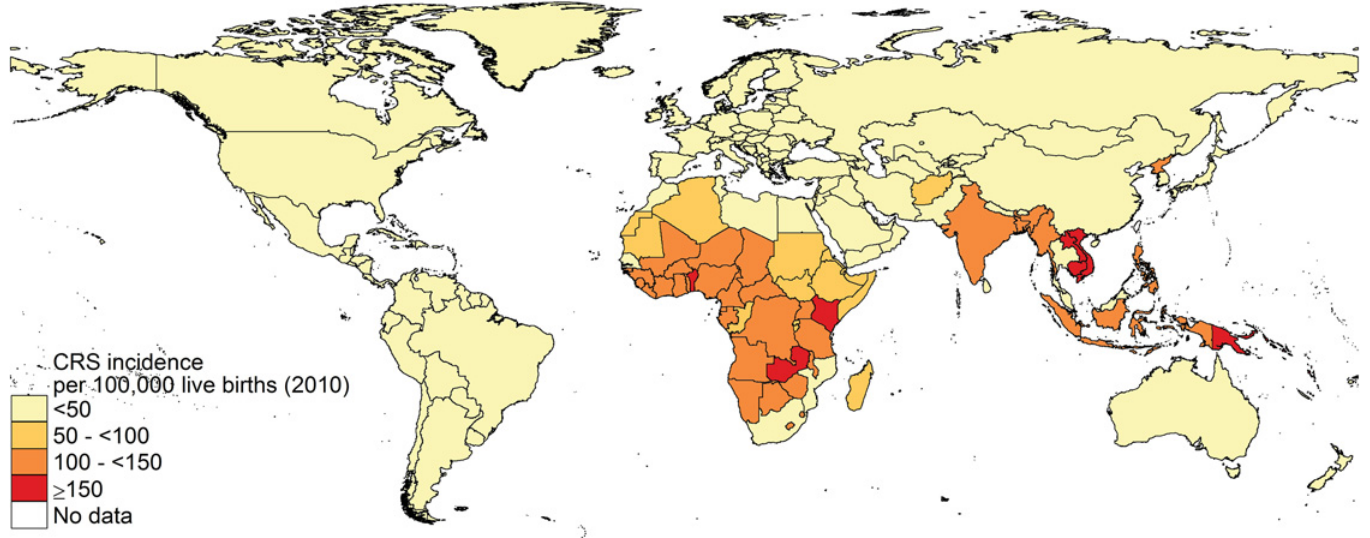
Fig 4. Estimates of the median incidence of CRS per 100,000 live births by country in